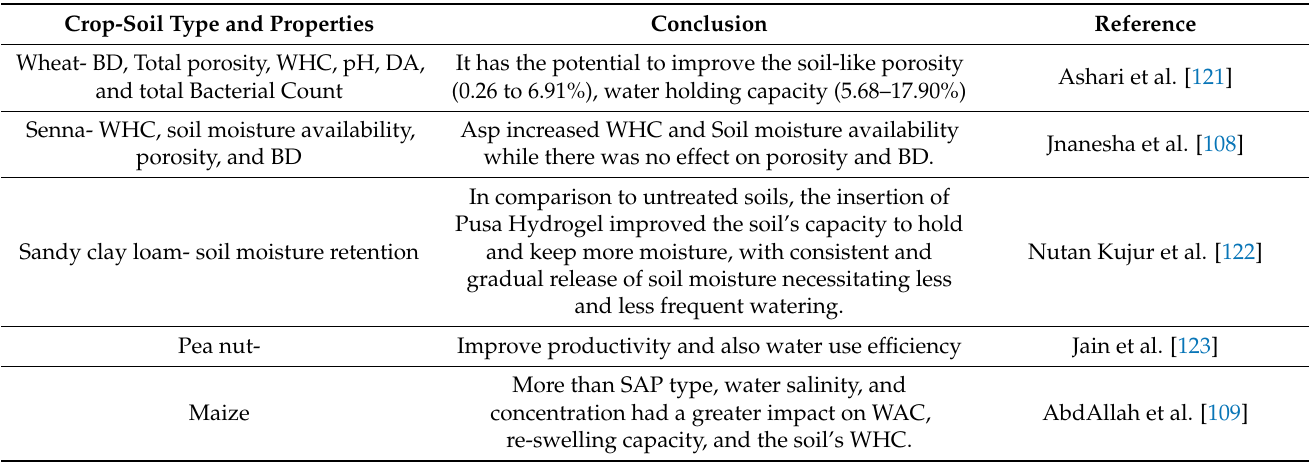
Table 5. Soil properties are affected by the application of super-absorbent polymers.